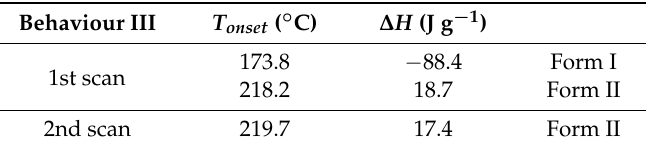
Table 4. Fusion–recrystallization of compound VA7J.